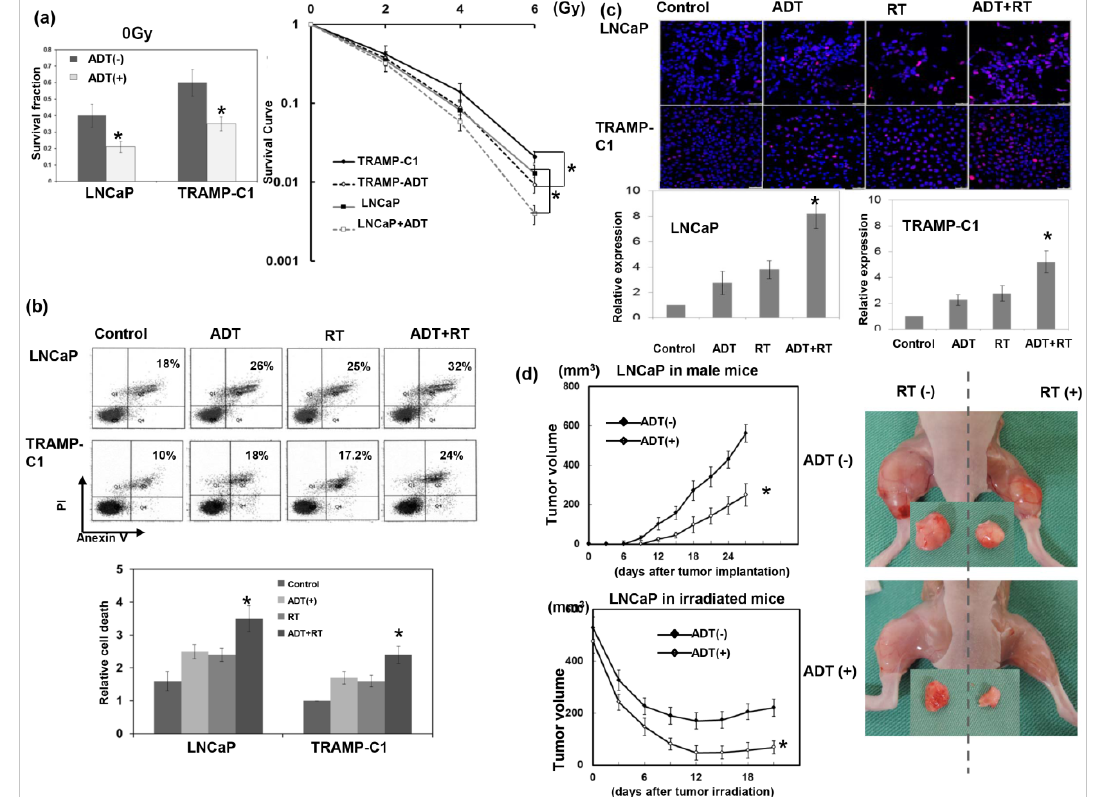
Figure 1. Effect of androgen deprivation therapy (ADT) on radiation sensitivities of prostate cancer. ( a ) Survival fractions were constructed using colony-forming assays for cells with or without ADT (10 μ M enzalutamide). In addition, a clonogenic assay was performed with prostate cancer cells with or without 10 μ M enzalutamide for 3 days before irradiation. The cells were irradiated with 0, 2, 4, or 6 Gy, and the survival curve was determined by colony counting and normalized with plating efficiency. Each point is an average of three experiments. ( b ) The in vitro effects of treatments on apoptosis as evaluated by fluorescence-activated cell sorting (FACS) with Annexin V-PI staining 48 h after irradiation. The y axis represents the ratio normalized by the value of TRAMP-C1 under control conditions. ( c ) DNA damage as evaluated by immunofluorescence staining with p-H2AX 24 h after irradiation. Scale bars: 50 μ m. The quantification was the calculation of the value of the cell numbers positive for p-H2AX divided by the total cell number. The y axis represents the ratio normalized by the value under control conditions. ( d ) The effects of ADT on tumor growth curves and the radiation response were examined using LNCaP ectopic tumors in mice with or without medical ADT. We also